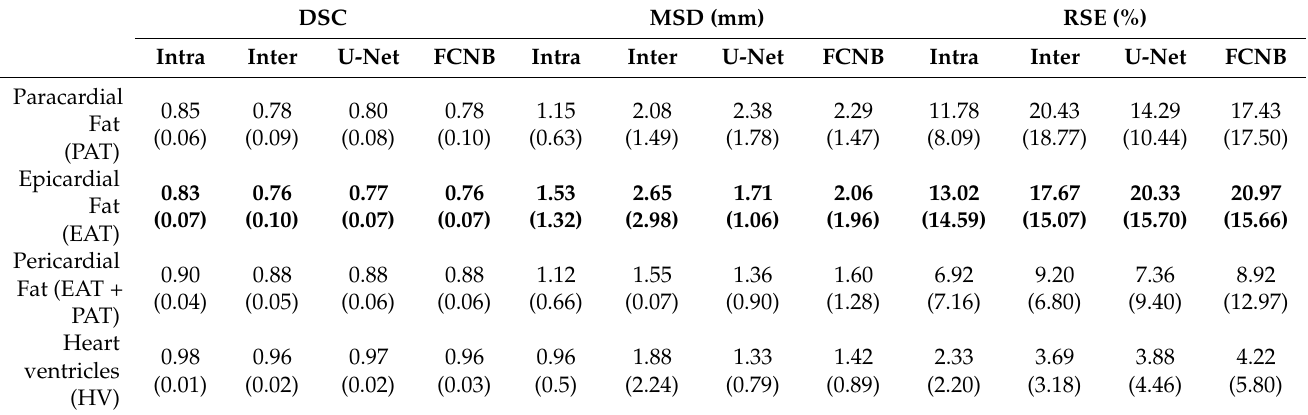
Table 2. Mean values and standard deviations (in parenthesis) of segmentation results on the test